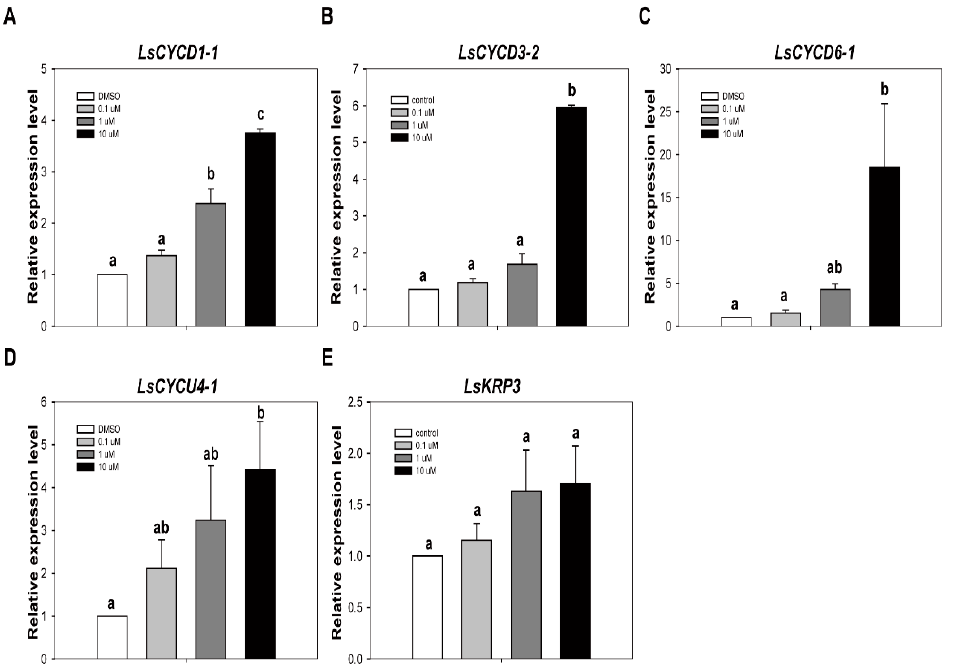
Figure 6. The effect of TSA on expression of cell division regulatory genes. The relative gene expression level of LsCYCD1-1 ( A ), LsCYCD3-2 ( B ), LsCYCD6-1 ( C ), LsCYCU4-1 ( D ) and LsKRP3 ( E ) in lettuce protoplasts. qRT-PCR was performed with total RNA extracted from lettuce protoplasts after treatment with DMSO or TSA for 12 hr. Bars represent means ± SE ( n = 3) of independent experiments. Different letters on the bars indicate significant differences between each treatment (ANOVA with Duncan’s test, p < 0.05).